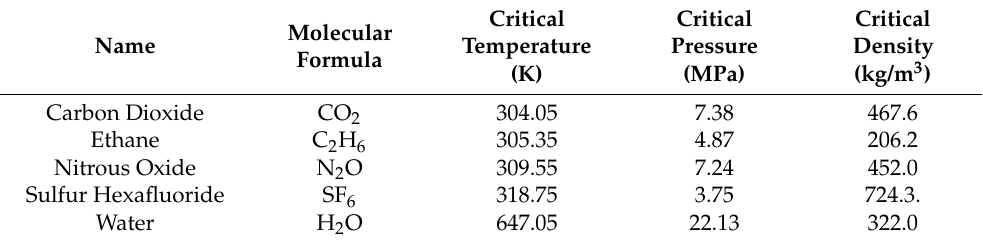
Table 1. Physical properties of the working medium at critical point